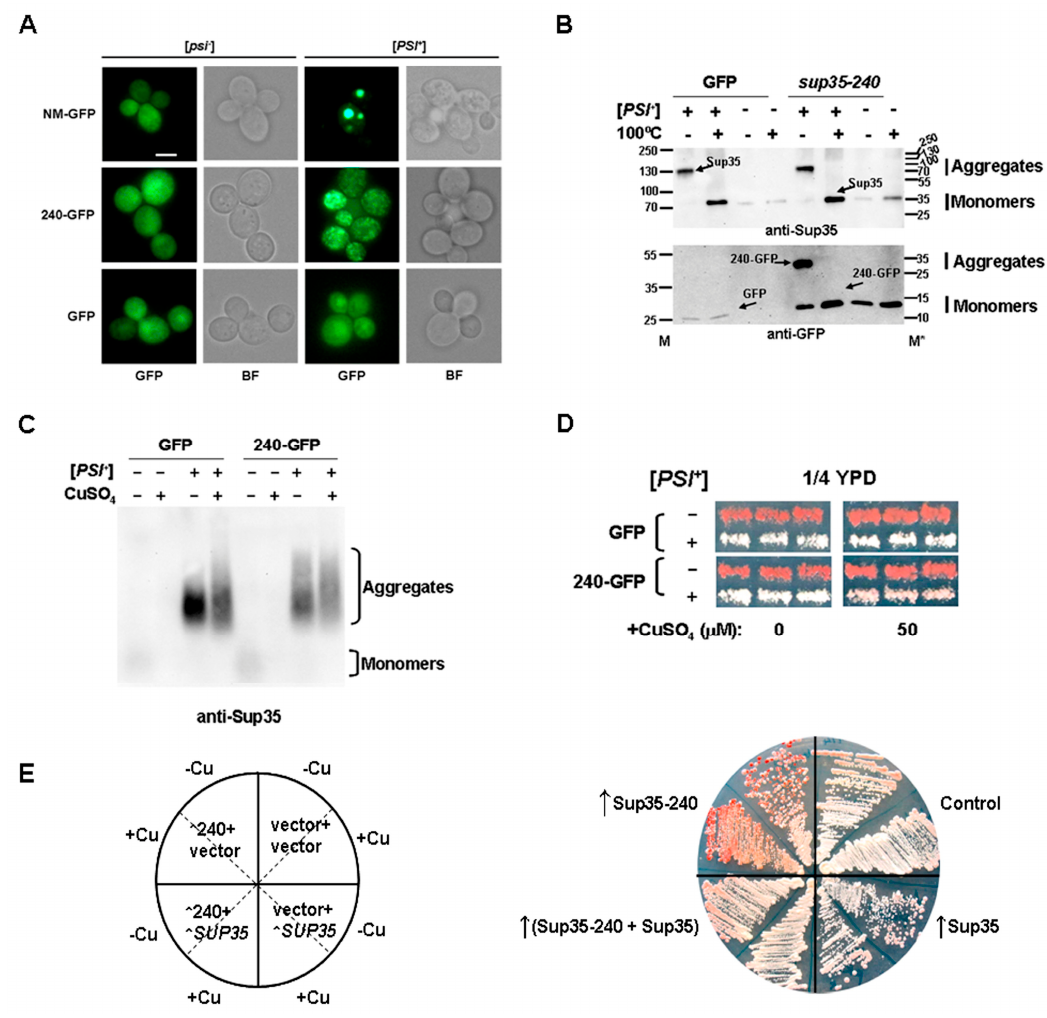
Figure 6. Sup35-240 is included in prion aggregates and leads to destabilization of the [ PSI + ] prion. ( A ) 10-7A-D832 [ PSI + ] and 7A-D832 [ psi − ] strains were transformed with pRS316-pCUP-GFP, pRS316-pCUP-SUP35NM-GFP, or pRS316-pCUP-sup35-240-GFP plasmids. Logarithmic yeast cultures were incubated in the presence of 50 µM CuSO 4 for two hours. Cells were visualized using fluorescent microscopy. Representative groups of cells are shown. Scale bar corresponds to 5 µm. BF—bright field. ( B ) Lysates of [ PSI + ] and [ psi − ] yeast cells shown at (A) were subjected to SDS-PAGE with additional boiling followed by immunoblotting with anti-Sup35 (upper panel) or anti-GFP (lower panel) antibodies. M—molecular weight marker (kDa) loaded at the beginning of electrophoresis (M) and after the gel boiling (M*). ( C ) The same [ PSI + ] and [ psi − ] transformants as in (A) were subjected to SDD-AGE followed by immunoblotting with anti-Sup35 antibodies. ( D ) Transformants shown at (A) were grown on 50 µ M CuSO 4 plates for 3 days, then transferred onto 1 / 4 YPD media to demonstrate the e ffi ciency of suppression. Six independent transformants were tested in each case. Representative results after 5 days of incubation at 30 ◦ C are shown. ( E ) OT56 ([ PSI + ]) strain was transformed with combination of following plasmids: pRS316-pCUP-GFP and pRS315 (vector + vector); pRS316-pCUP-GFP and pRSU1 (vector + SUP35 ); pRS316-pCUP-sup35-240-GFP and pRS315 (240 + vector); pRS316-pCUP-sup35-240-GFP and pRSU1 (240 + SUP35 ). Transformants were grown during 6 days on selective media under non-induced ( − Cu) or induced ( + Cu) conditions (50 µ M CuSO 4 was used), then transferred onto 1 / 4 YPD media for 5 days of incubation at 30 ◦